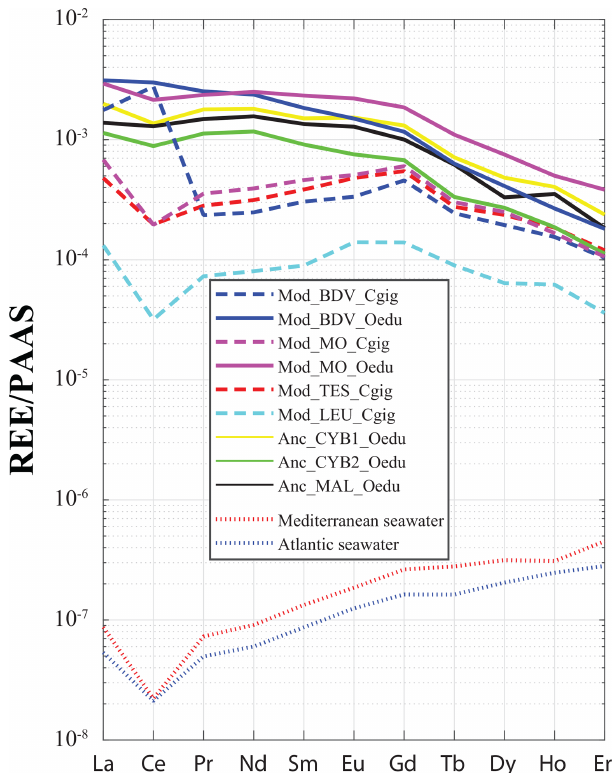
Figure 5. REE median profiles for all groups of oyster specimens. Crassostrea gigas groups are symbolized by dashed lines, and con- tinuous lines are for O. edulis groups. Seawater profiles of the At- lantic Ocean (van der Flierdt et al., 2012) and the Mediterranean Sea (Censi et al., 2004) are indicated for comparison. Values are normalized to Post-Archean Australian Shale (PAAS) according to McLennan (1989).